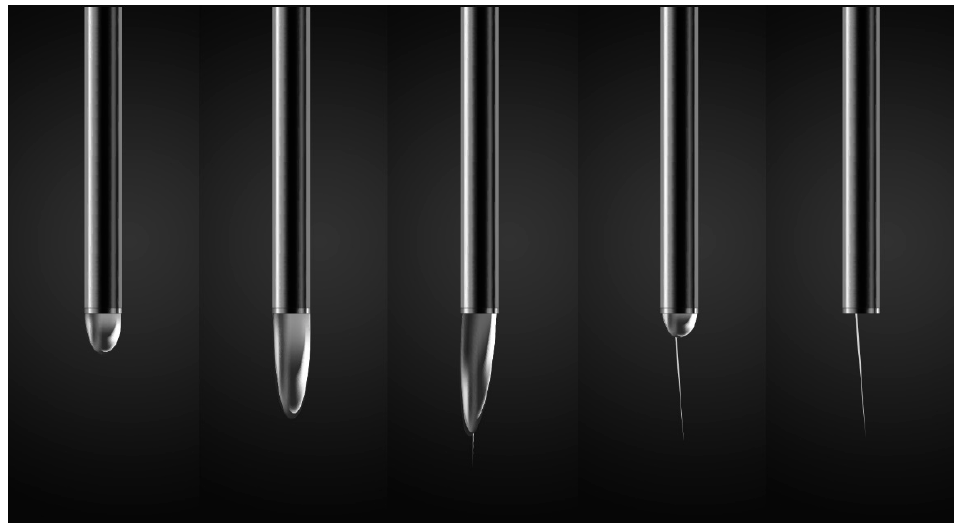
Figure 14. Formation of a Taylor cone with the increase of applied voltage.